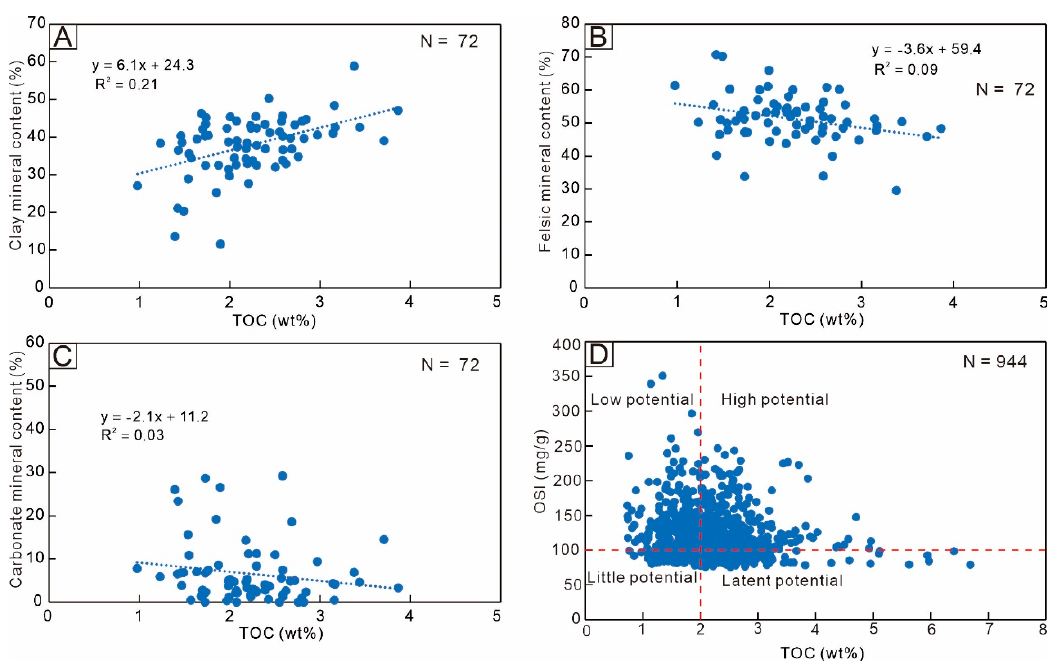
Figure 21. Cross plots showing the correlation of TOC and mineral content as well as S 1 /TOC. ( A ) The relationship between TOC and clay mineral content; ( B ) The relationship between TOC and felsic mineral content; ( C ) The relationship between TOC and carbonate mineral content; ( D ) The relationship between TOC and OSI.